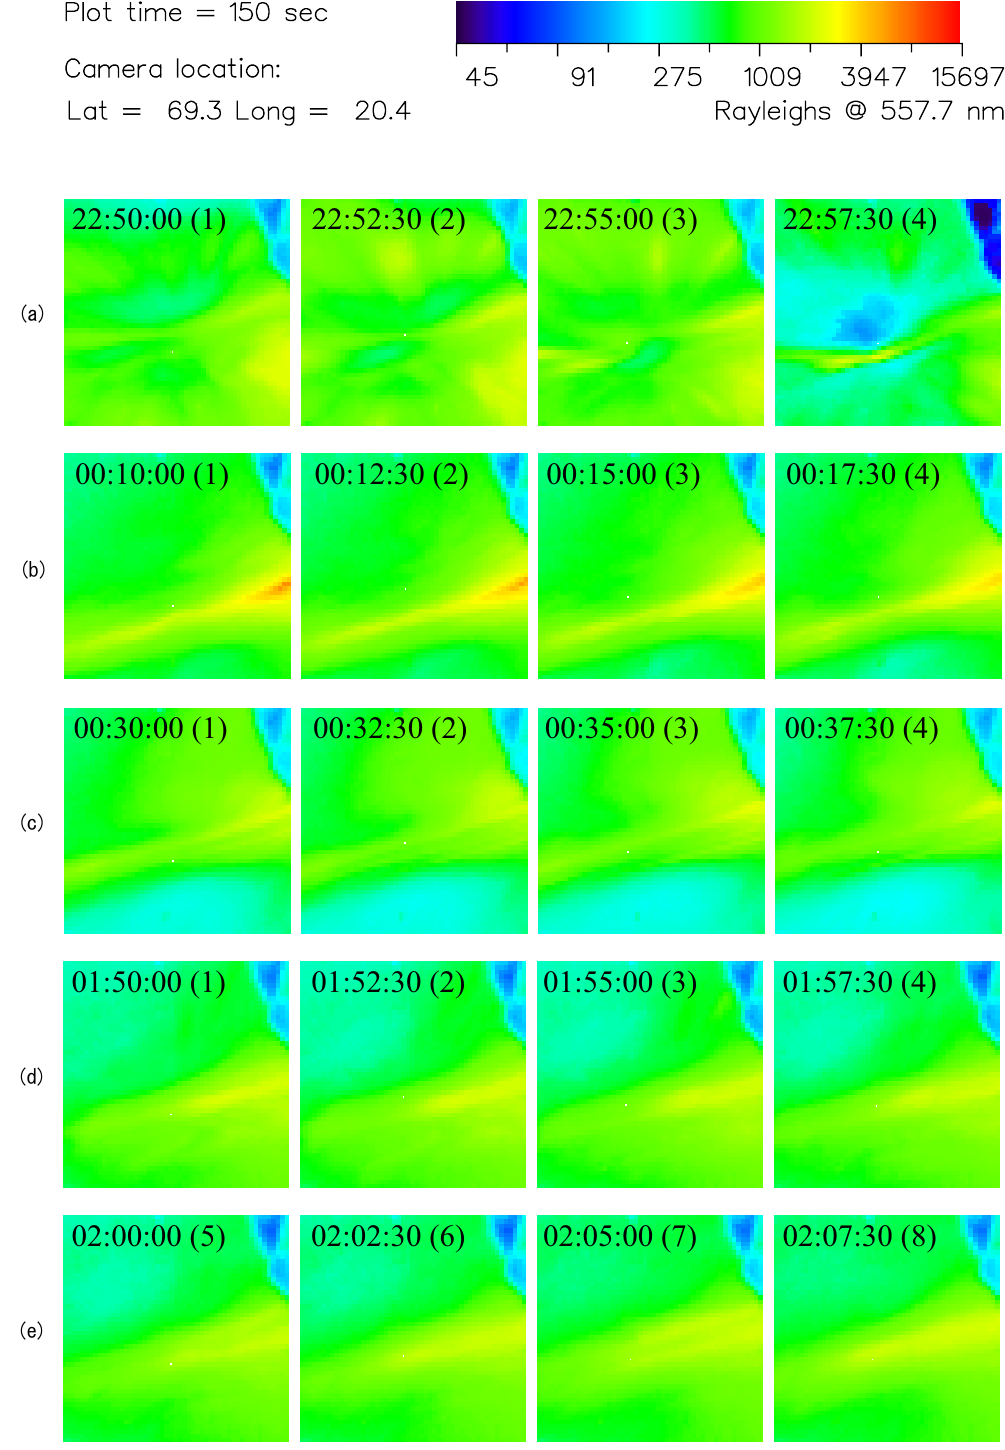
Fig. 4. All-sky images of the selected events. The spatial coverage is 67.6–72.6 ◦ N, 13.5–26.0 ◦ E geographic (about 520 × 520km) at 10 × 10km resolution. Mapping is for 100km altitude. The intensity is calibrated in Rayleighs for 557.7nm. The white dot near the center of each image is the position of the EISCAT radar beam at 100km altitude. The observation starting time (UT) and beam position corresponding to numbers (1–8) are noted in the top of each image. The dark triangle in the top right corner of every image is the mountain near Skibotn,